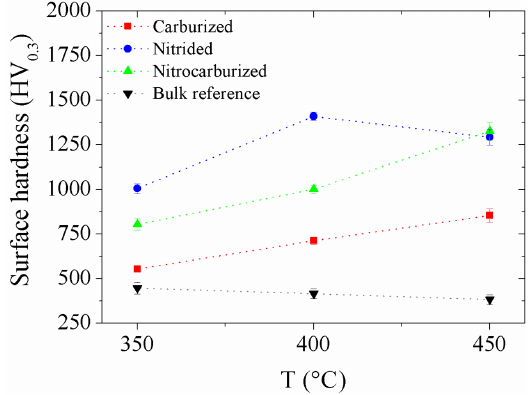
Figure 4. Surface hardness of the treated samples as a function of the treatment temperature (for treatments carried out at 8